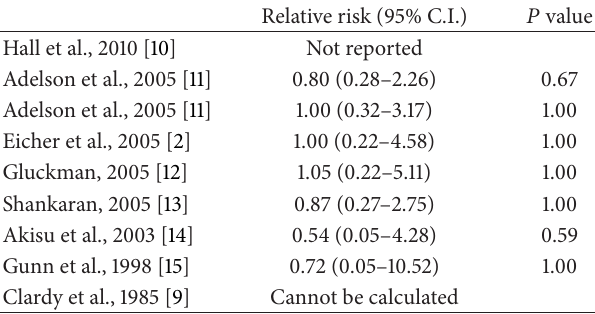
Table 2: Relative risk and 𝑃